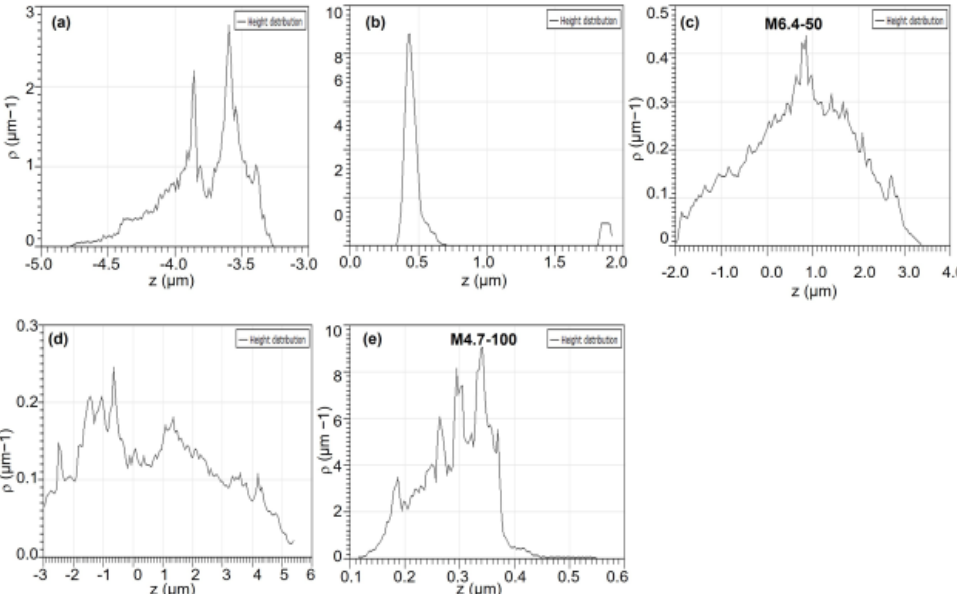
Figure 7. Topological distributions of dry hydrogel samples: ( a ) PZ-30, ( b ) PZ-50, ( c ) M6.4-50, ( d ) M6.4-100, and ( e ) M4.7-100.